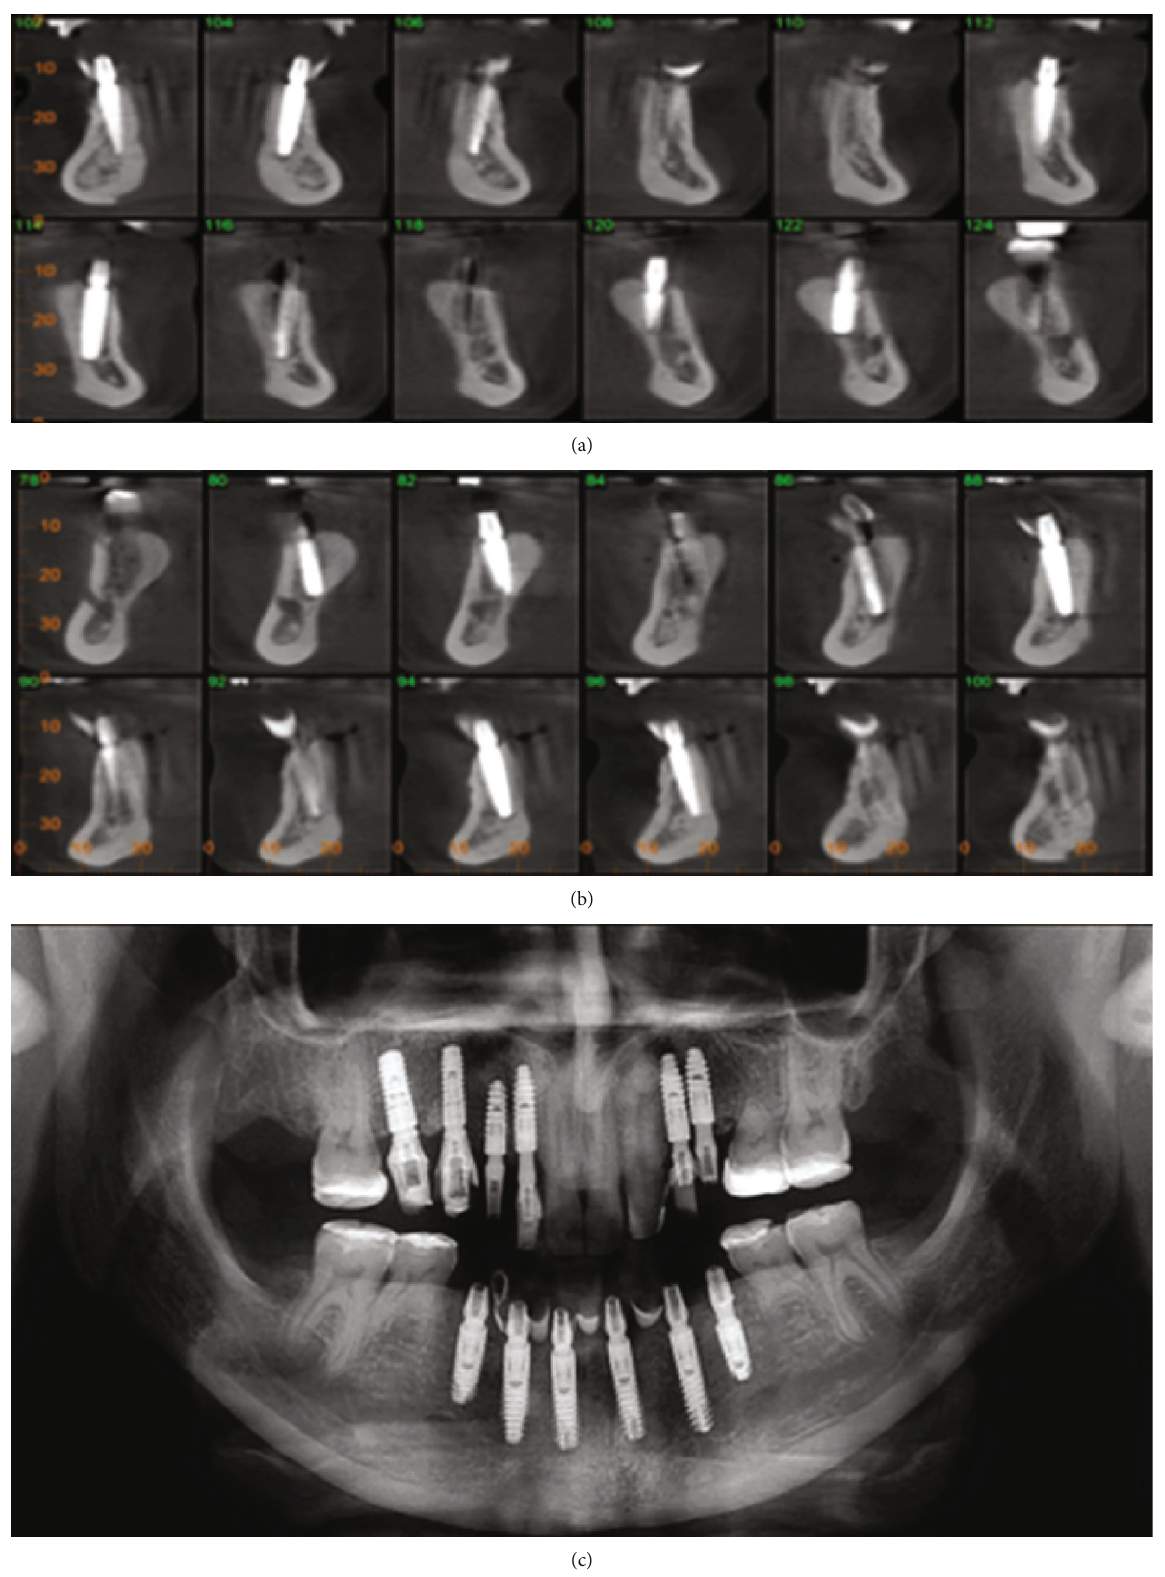
Figure 9: Four-year follow-up CT, showing the stability of the bone tissue around the implants (a, b). Panoramic radiograph of the 4-year follow-up